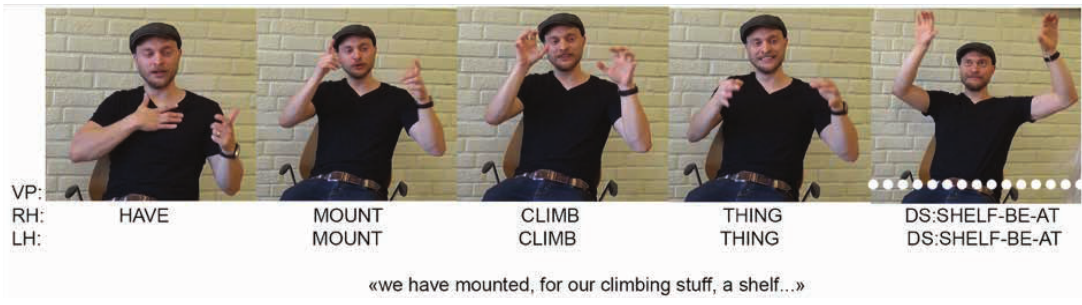
Figure 2: During the last sign of this utterance, the signer positions himself within a conceptualized scene as he depicts a shelf that is positioned above him on a wall, i.e., character perspective (DPNTS_O_PN.eaf, 00:36:03.029-00:36:05.605). 1 Examples in this paper are presented as a series of still shots. At the bottom of the images, a white dotted line is used to indicate which parts of the sequence portray a vantage point (labeled �� ). Below the images are English glosses of the manual signs produced on the right ( �� ) and left hands ( �� ). Prefixes indicate if signs are pointing signs ( ��: ), depicting signs ( ��: ), and fingerspelling ( ���: ) (see also section ‘Annotation and analysis’). Fragment buoys, which are meaningful perseverations of signs, are labeled ����� . Signs labeled as ‘?’ indicate ambiguity or uncertainty from the annotator about how to best gloss the sign. Translations of the examples in English are also